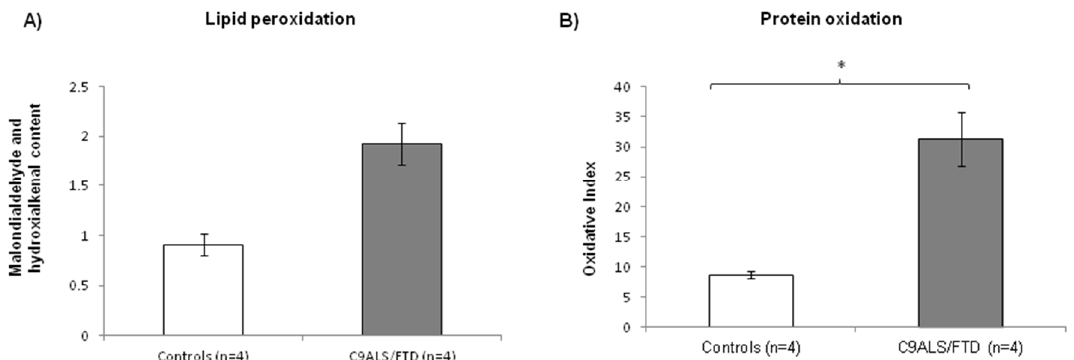
Figure 2. Oxidative stress measured through ( A ) lipid and ( B ) protein peroxidation in C9ALS/FTD patients and the control samples. C9ALS/FTD patients exhibited an upward trend in lipid peroxidation compared to the control fibroblasts and a significantly increase in protein oxidation levels (oxidative index as protein carbonyls). The results are expressed as means ± standard error of the mean (SEM). * p < 0.05.